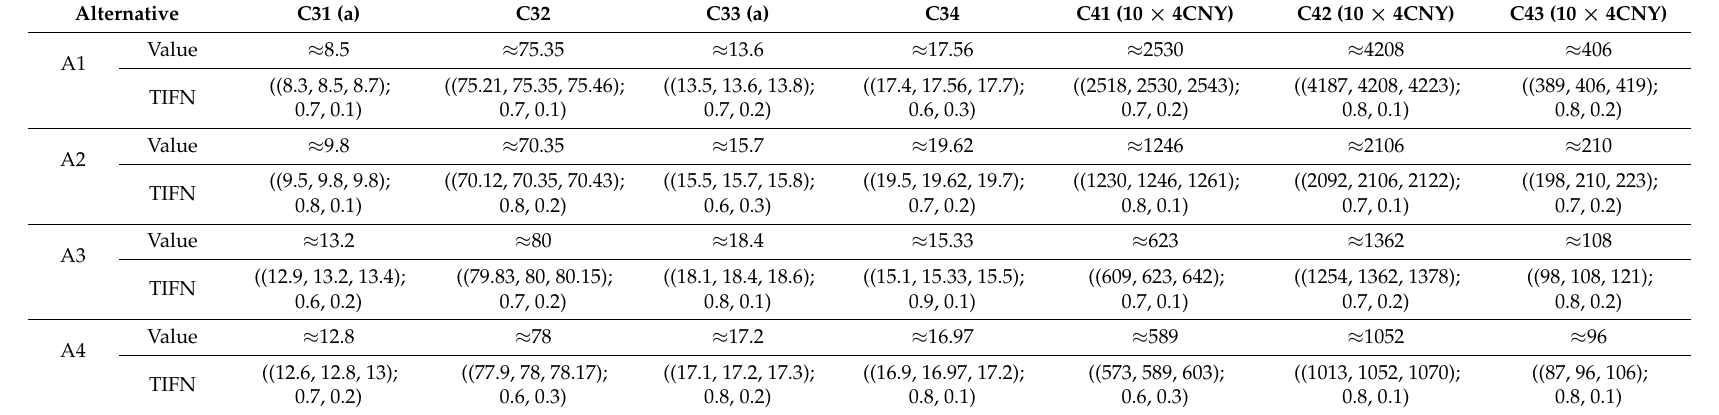
Table 3. Performance numerical and triangular intuitionistic fuzzy numbers (TIFNs) values of the second type